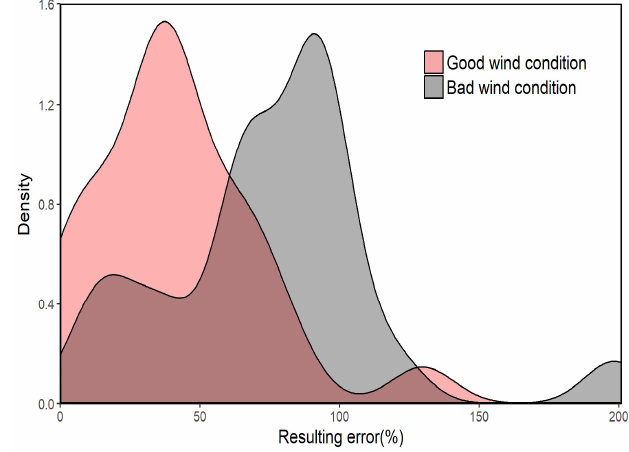
Figure 11. Distribution of resulting error under good wind condition (red shadow) and bad wind condition (grey shadow).